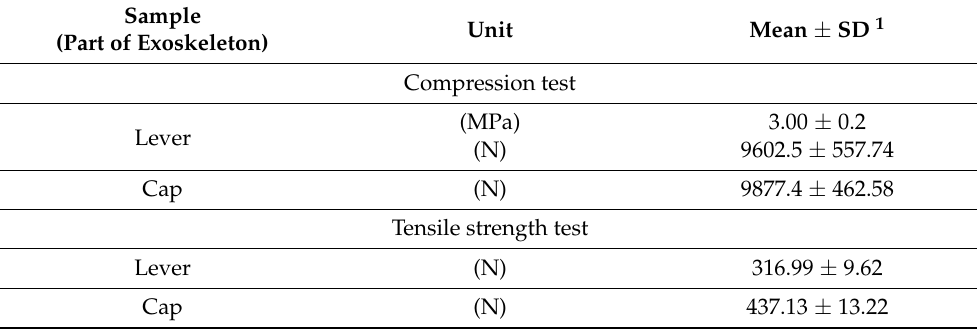
Table 1. Strength test results.